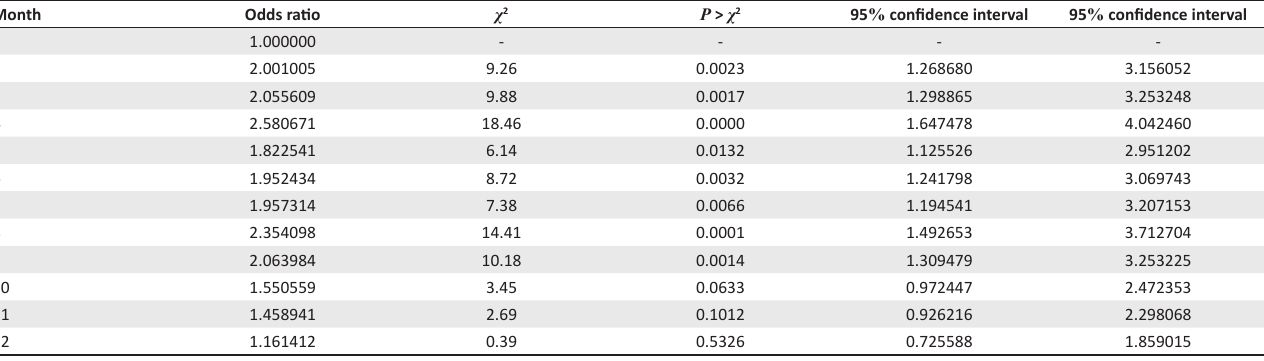
TABLE 2-A1: Case–control evaluation of monthly lamb wastage using logistic regression analysis.